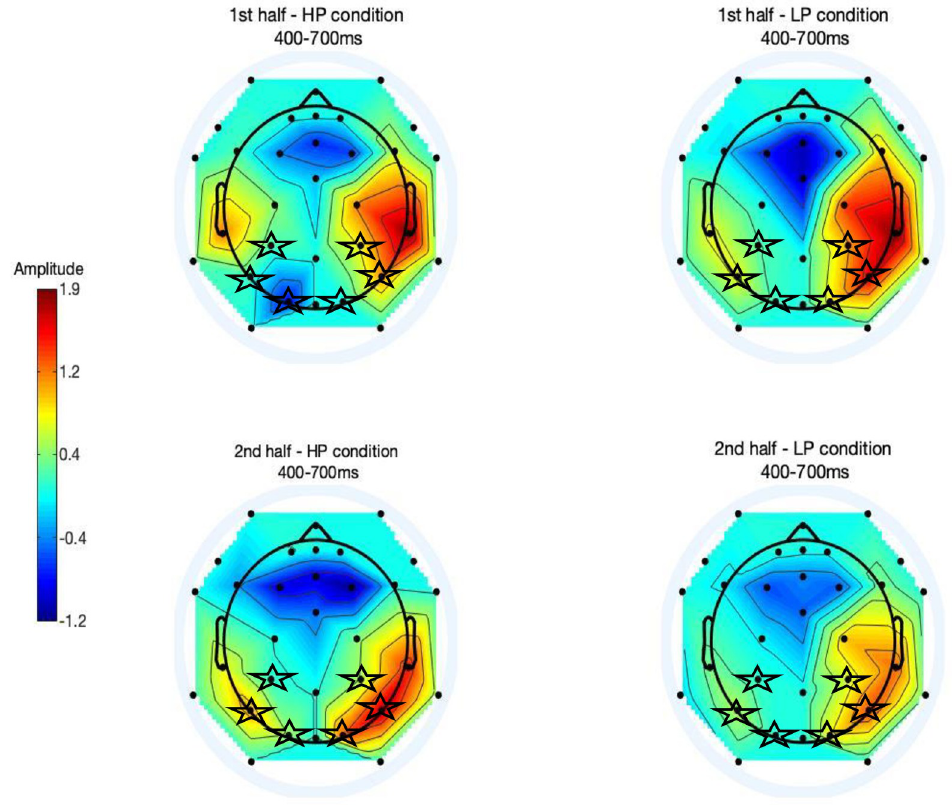
Fig 5. Topographical maps depicting ERP amplitudes averaged across electrodes in 400–700 millisecond time- window after predictor onset. Maps are shown for the first half of the task for the high-probability (top left) and the low-probability (top right) conditions. Likewise, maps are shown for the second half of the task for the high-probability (bottom left) and low-probability conditions (bottom right). The 6 electrodes of the a priori posterior region used in the waveform analyses are marked by